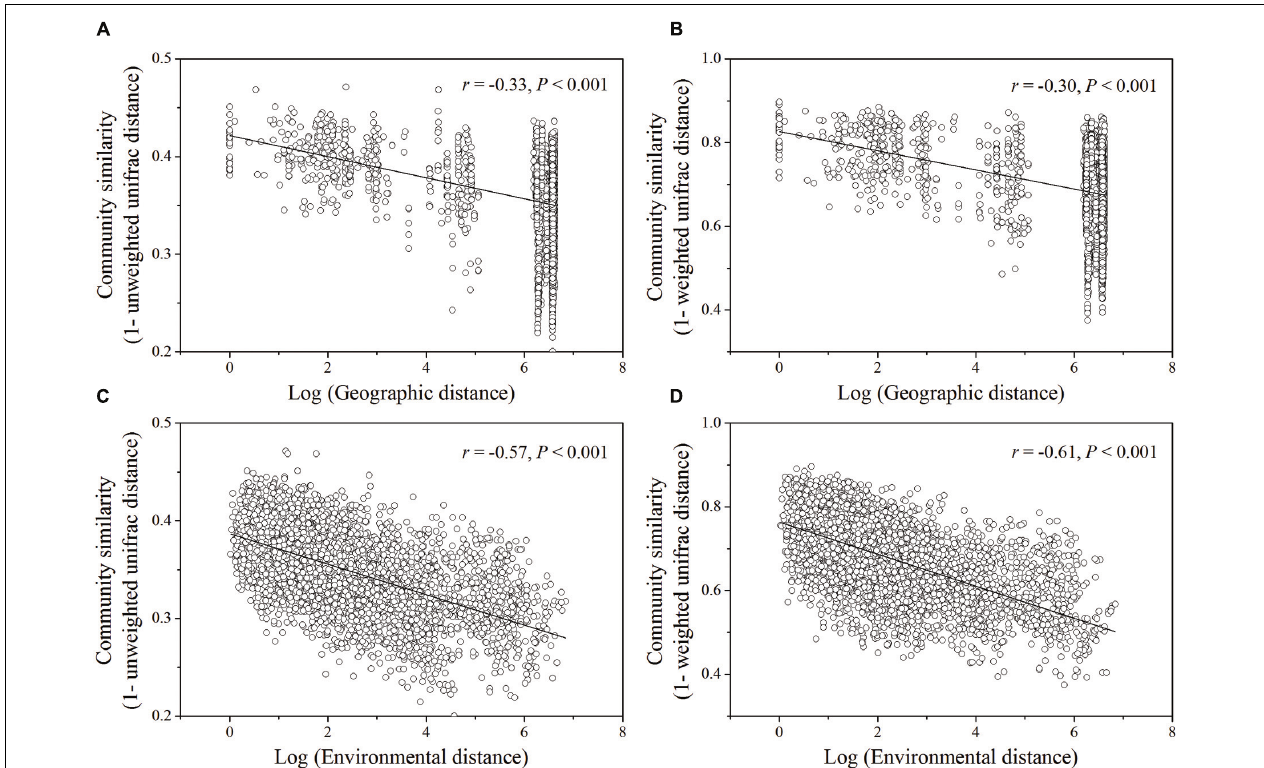
FIGURE 8 | Relationships between log of geographic distance (A,B) or environmental distance (C,D) and bacterial community similarity. The significant vectors formed during PCNM analysis of geographic coordinates of sampling sties were used to construct geographic distance matrix. The environmental variables (pH, ECa, NH + 4 ) used to estimate environmental distance were selected by BioEnv procedure. Bacterial community similarity was estimated by pairwise Unifrac distance (unweighted or weighted) in community composition.